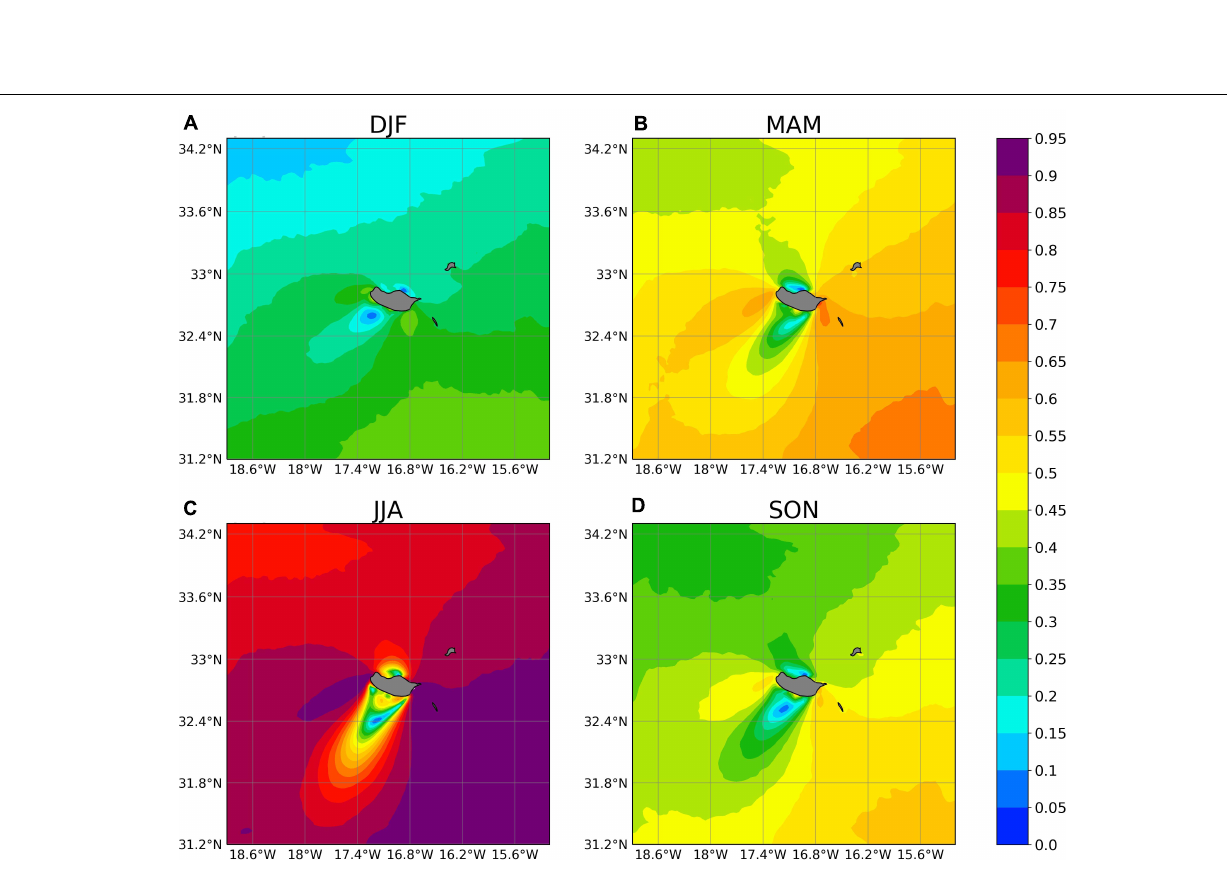
Frontiers in Marine Science |